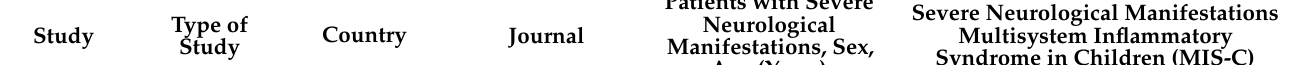
Table 1. Characteristics of the studies included in the